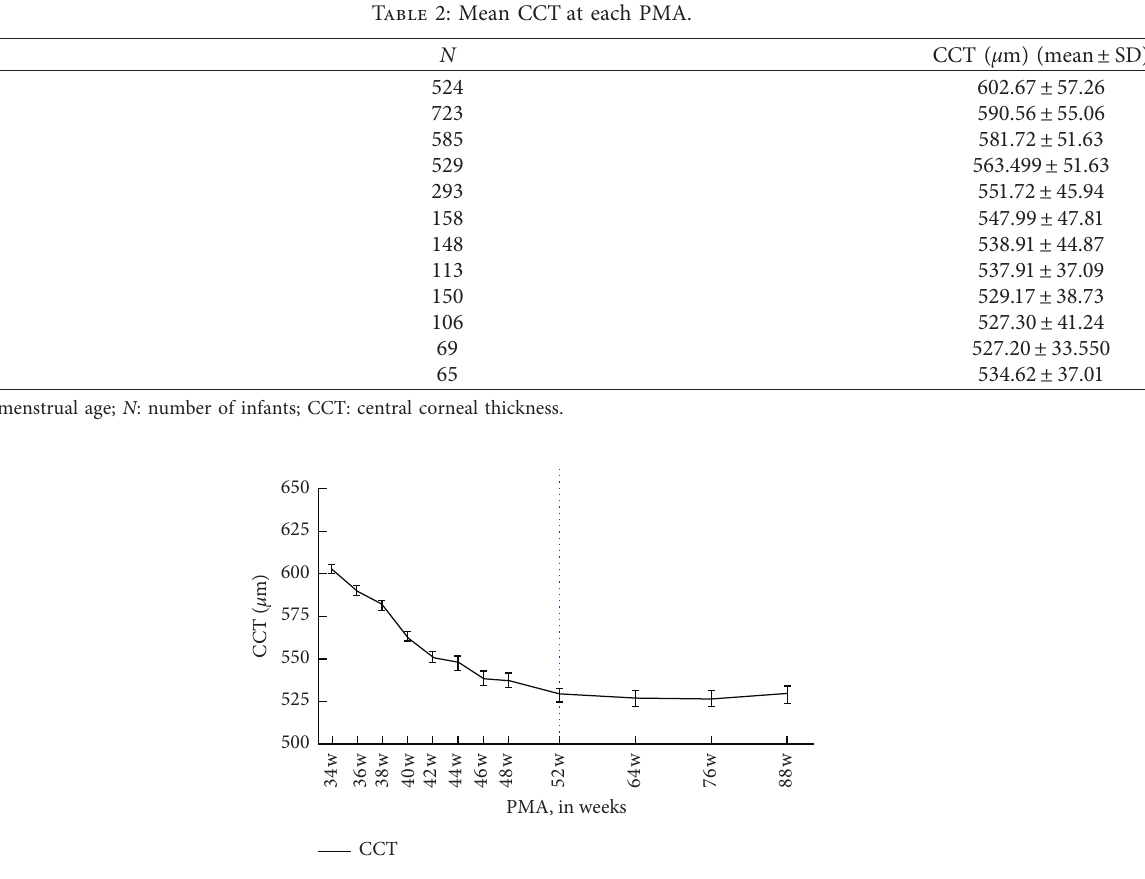
Figure 1: Trend of CCT. PAM: postmenstrual age; CCT: central corneal thickness. Correlation between PMA and CCT before 52w: y � − 4.241 x +739.5; correlation between PMA and CCT after 52w: y � 0.08250 x